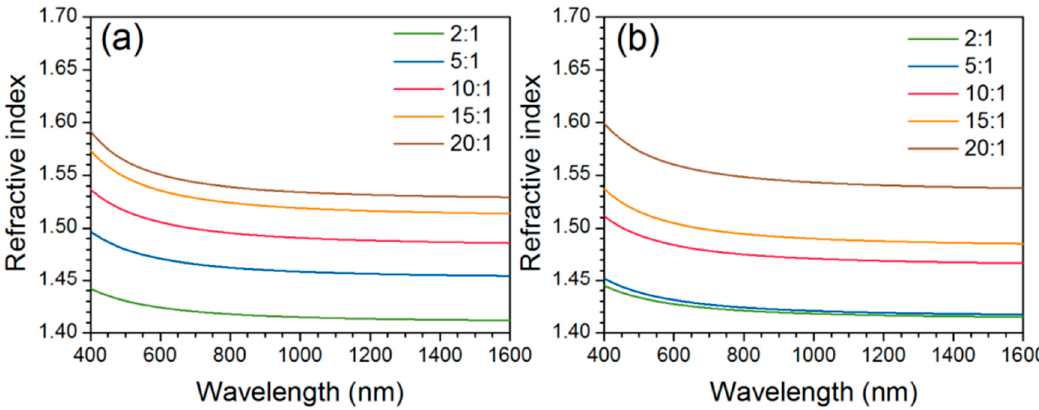
Figure 16. Changes in the refractive indices for PDMS–TiO 2 hybrid films for different TIP/PDMS–OH molar ratios (shown in the legend), using PDMS–OH with viscosities of ( a ) 25 cSt; and ( b ) 65 cSt, corresponding to average molar masses of 2100 and 4000 g mol − 1 , respectively (calculated based on experimental measurements from [85]). Reproduced with permission from Dalod et al. Nanomaterials ; published by MDPI, 2017.